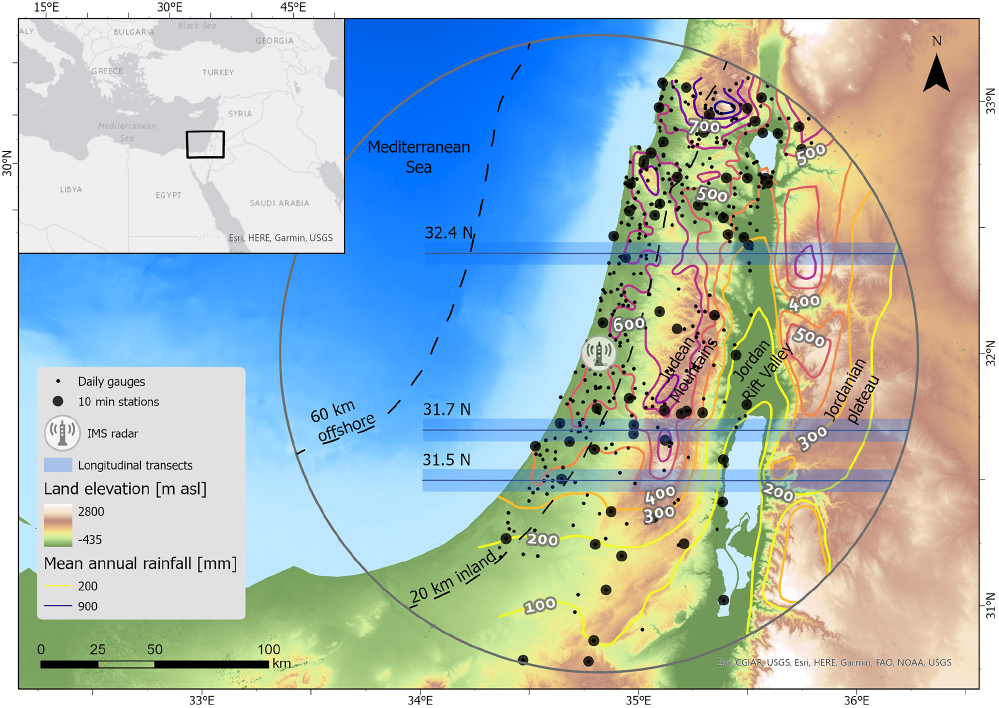
Figure 1. Map of the study area showing the terrain elevation, location of the weather radar, 140km range of the instrument, location of the daily rain gauges, location of the 10min rain gauges, and locations of the three transects shown in Figs. 6 and 7. Mean annual rainfall is based on 1961–1990 rain gauge data (Enzel et al.,